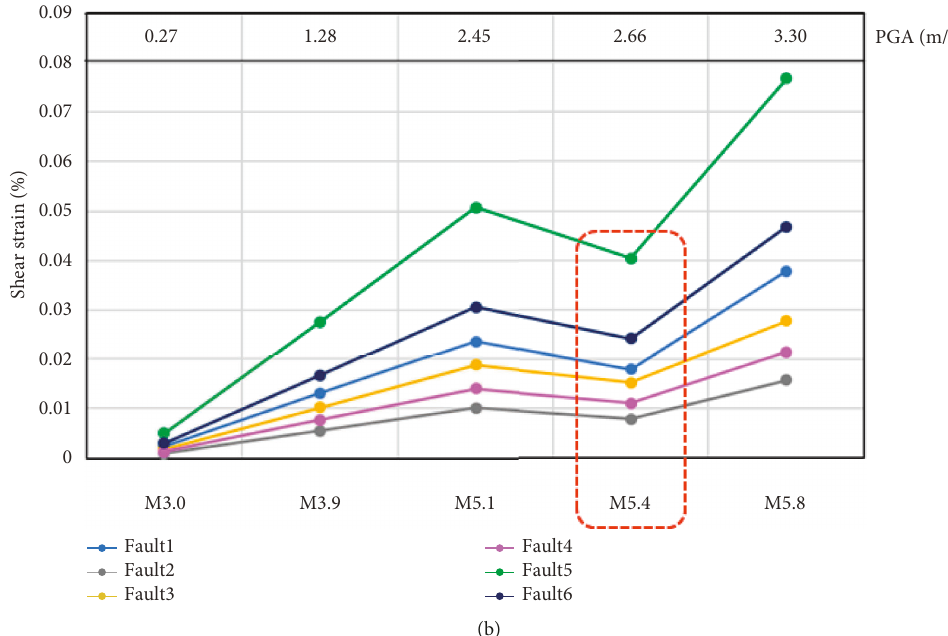
Figure 9: (a) Maximum shear stress and (b) maximum shear strain of the six fault gouges for each earthquake magnitude. The maximum shear stress and strain increase as the magnitude increases. However, both the maximum shear stress and strain for the M5.4 earthquake are lower than those for the M5.1 earthquake.